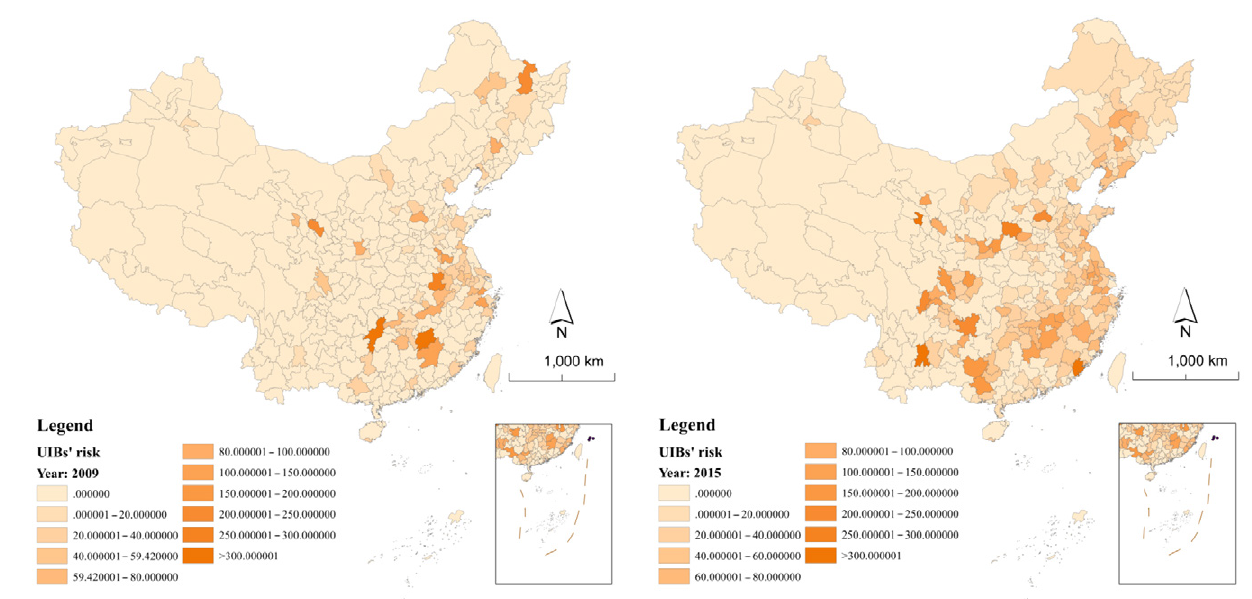
Figure 2. Debt burden risk at prefecture-level in 2009 Figure 3. Debt burden risk at prefecture-level in